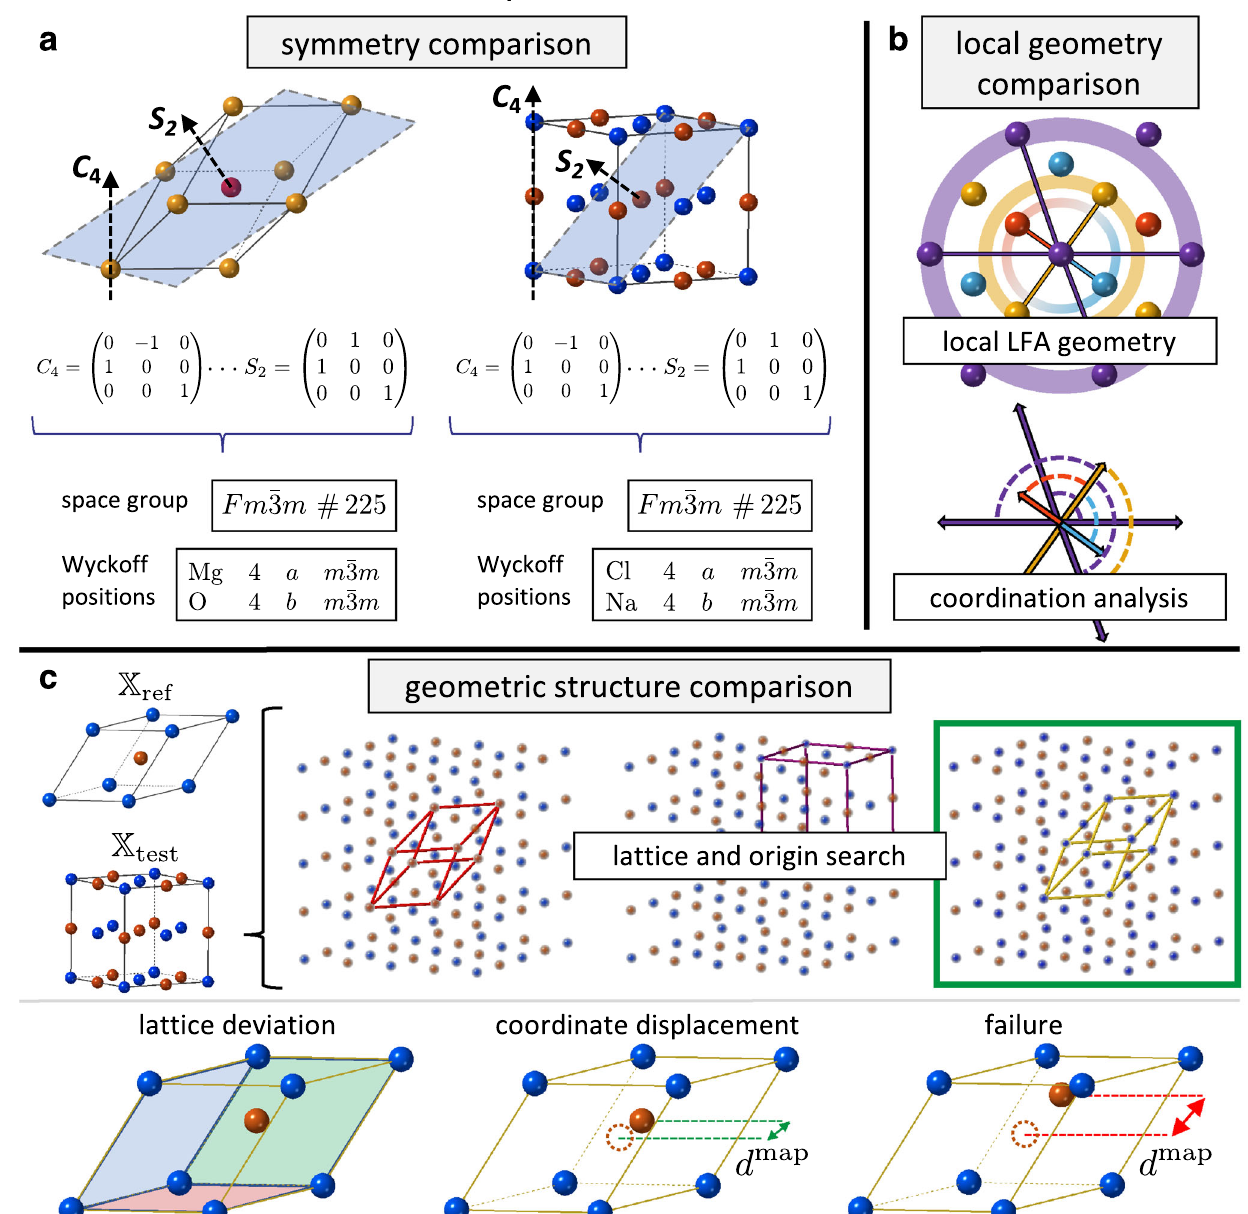
Fig. 2 Symmetry, local atomic geometry, and geometric structure comparisons in AFLOW-XtalFinder. a Crystal isometries are calculated internally with AFLOW-SYM. The space groups and occupied Wyckoff positions are compared, revealing isopointal structures. b The local least-frequently occurring atom (LFA) geometries are computed and compared between structures. An example local LFA geometry (2-D projection) is shown for the quaternary Heusler structure (ABCD_cF16_216_c_d_b_a) 17,18 , highlighting the closest neighbors (via solid lines) for each LFA type to the central Mg atom (purple). Shaded concentric circles indicate the tolerance threshold for capturing atoms in the coordination shell with a thickness of 10% of the distance from the central and connected atom. Local geometry vectors are compared against local geometries in other structures to determine mapping potential. c Two structures ( X ref and X test ) are mapped onto one another by expanding X test into a supercell and exploring commensurate lattice and origin choices with respect to X ref . The yellow lattice (highlighted e X by the green box) is a potential match with X ref . X test is transformed into the new representation ( test ), and the structures are quantitatively compared via the mis fi t criteria. The structures are evaluated via their lattice deviation ( ϵ latt ), coordinate displacement ( ϵ coord ), and fi gure of failure ( ϵ fail ). Distances between mapped atoms ( d map ) that are less than half the atom ’ s nearest neighbor ( d nn /2) are accounted for in the coordinate displacement (green dashed lines and arrows), while larger distances are described in the fi gure of failure (red dashed lines and